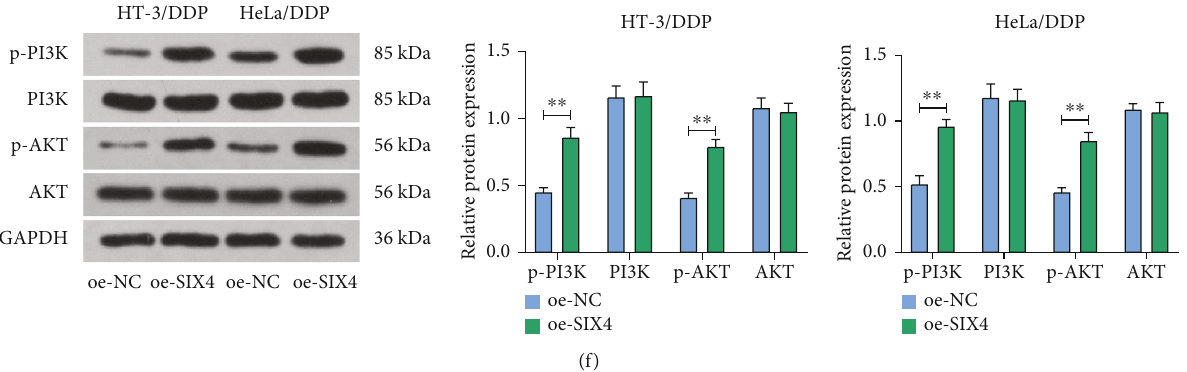
Figure 4: Overexpression of SIX4 activates the PI3K/AKT signaling pathway to promote CC cell growth and chemoresistance to DDP. (a) Detection of SIX4 mRNA expression in HT-3/DDP and HeLa/DDP cells by RT-qPCR. (b) The proliferation of cells measured using colony formation assay. (c) The cell viability measured using EdU assay. (d) The invasive ability of cells determined using Transwell assay. (e) The chemoresistance of cells to DDP measured using MTT assay. (f) The protein expression of p-PI3K, PI3K, p-AKT, and AKT in cells examined using Western blot. Data among multiple groups were analyzed by two-way ANOVA followed by Tukey ’ s post hoc test ( ∗ p < 0 : 05 ; ∗∗ p < 0 : 01 ). The cell experiment was independently repeated three